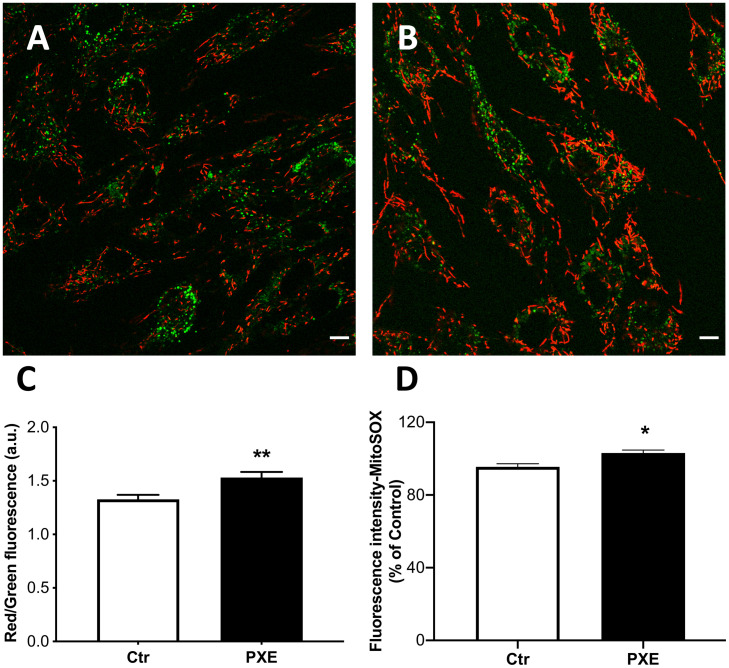
Representative images of mitochondrial membrane potential evaluated in mitochondria from control (Ctr) (A) and Pseudoxanthoma elasticum (PXE) (B) fibroblasts stained with JC-1 and observed by confocal microscopy in a live-imaging mode. The mitochondria in PXE cells were predominantly in red form, indicating a higher membrane potential than those present in control fibroblasts. Bar = 10 μm. (C) Histogram showing the ratio of red to green fluorescence intensity measured on control and PXE fibroblasts. (D) Mitochondrial O2⋅– levels detected in Ctr and in PXE fibroblasts by MitoSOX-based flow cytometry. Data are expressed as mean ± SEM of three independent experiments conducted in triplicate on each cell line. *p < 0.05; **p < 0.01PXE vs Ctr.